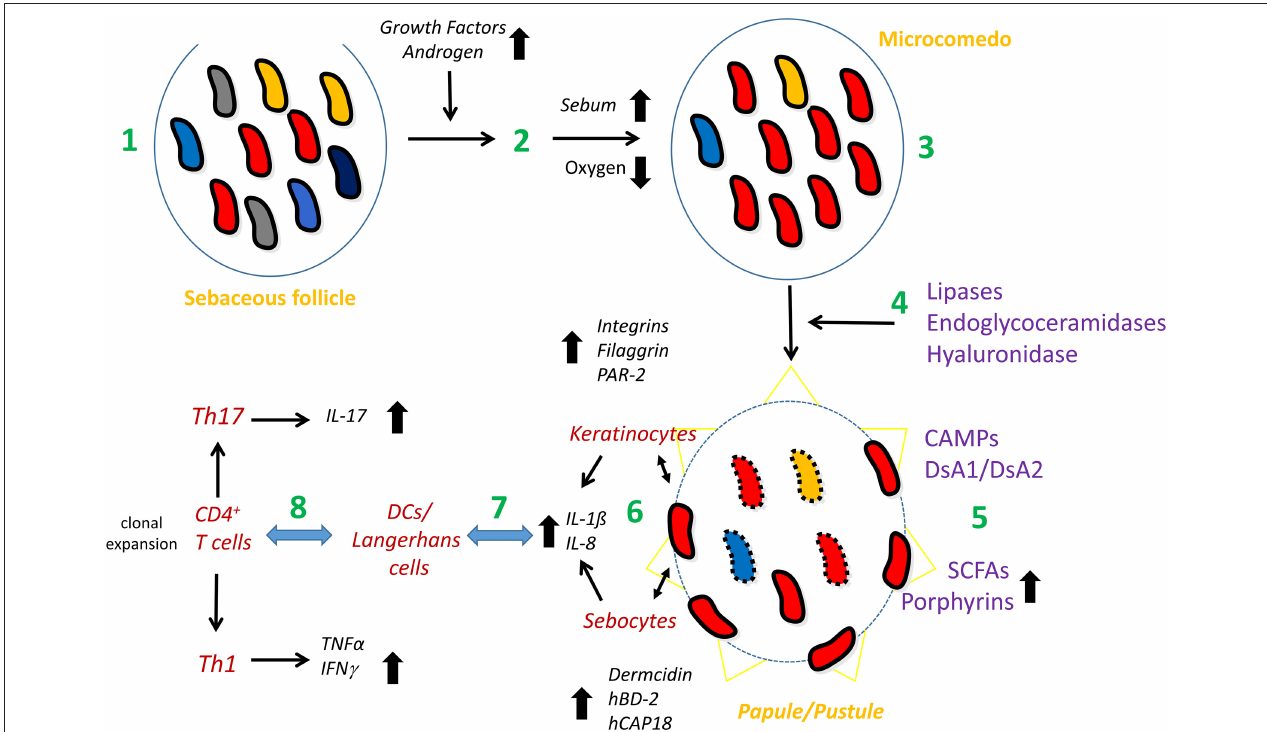
FIGURE 3 | Model of the possible involvement of C. acnes in acne vulgaris. The healthy pilosebaceous unit is colonized with a mixture of different C. acnes phylotypes/strains (1). Androgen and growth hormone levels in the puberty age rise; these activate sebaceous glands to produce more sebum (2). Exceeding sebum and hyperkeratinization lead to the clogging of the sebaceous duct, the infrainfundibulum, and therefore, to microcomedo formation (acne precursor lesion). The follicular homeostasis is disrupted; the microenvironment of the microcomedo is more anaerobic, providing an advantage and/or disadvantage for different C. acnes phylotypes/strains, resulting in the predominance of type IA 1 (SLST types A and C) and/or IA 2 (SLST type F) strains in the comedo (3). Type IA 1 /IA 2 strains produce and secrete host-tissue degrading enzymes such as a type IA-specific hyaluronidase, endoglycoceramidases and lipases; the latter lead to the accumulation of free fatty acids (4). In addition, type IA 1 /IA 2 strains produce CAMP factors (CAMP1 and 2) as secreted and cell surface-attached proteins and the adhesive surface glycoproteins dermatan-sulfate adhesins/fibrinogen-binding proteins (DsA1/DsA2). They also secrete short-chain fatty acids such as propionate and produce porphyrins at higher levels (5). These bacterial properties further modulate the follicular microenvironment and pave the way for a closer contact of the bacterium with the cellular microenvironment of the follicle (6), including keratinocytes and, possibly, sebocytes. The direct (bacterial surface) or indirect (secreted factors) contact of C. acnes with these cells activates a local innate immune response, mainly in a TLR2-dependent manner, resulting in the release of chemokines/cytokines, such as IL-8, IL-1 β and others, and can also lead to the production of defense factors (6). Skin-resident DCs/Langerhans cells and macrophages sense and/or are recruited to and infiltrate the irritated tissue site (7). They also interact with skin-resident CD4 + T cells, resulting in clonal expansion ( C. acnes clone-specific proliferation of T-cells). Mixed Th1/Th17 responses result in the secretion of other cytokines including IFN- γ and IL-17 (8). Together, this leads to the formation of papules and pustules as seen in inflammatory